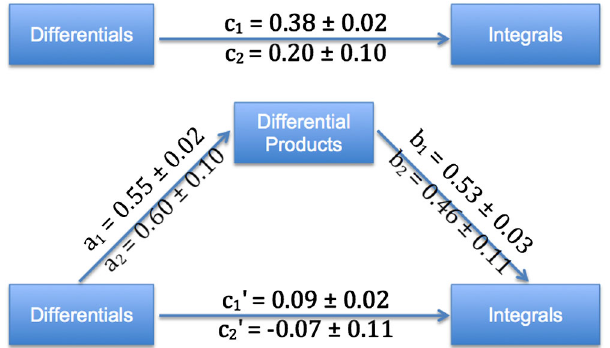
FIG. 2. Top: A visual representation of the total effect of our simple mediation model. The regression coefficient estimating the total effect is shown for both Physics 1 and Physics 2 populations as c 1 and c 2 , respectively, with 1 standard error. Bottom: A visual representation of the direct and indirect effects of our simple mediation model. The regression coefficients are shown for both Physics 1 and Physics 2 populations with subscripts “ 1 ” and “ 2, ” respectively, with 1 standard